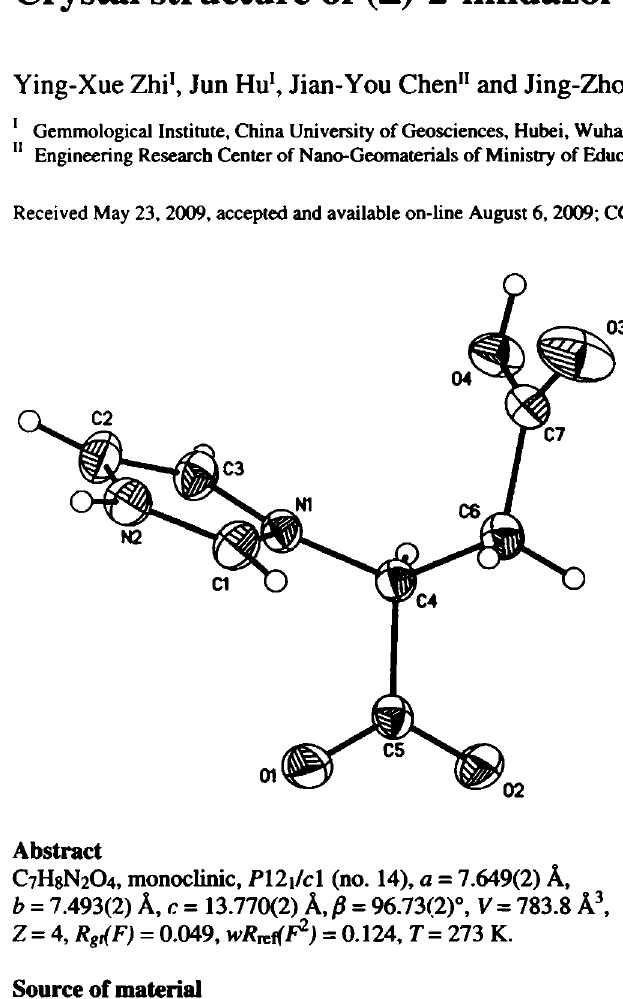
Table 3. Atomic coordinates and displacement parameters (in Â 2 ).